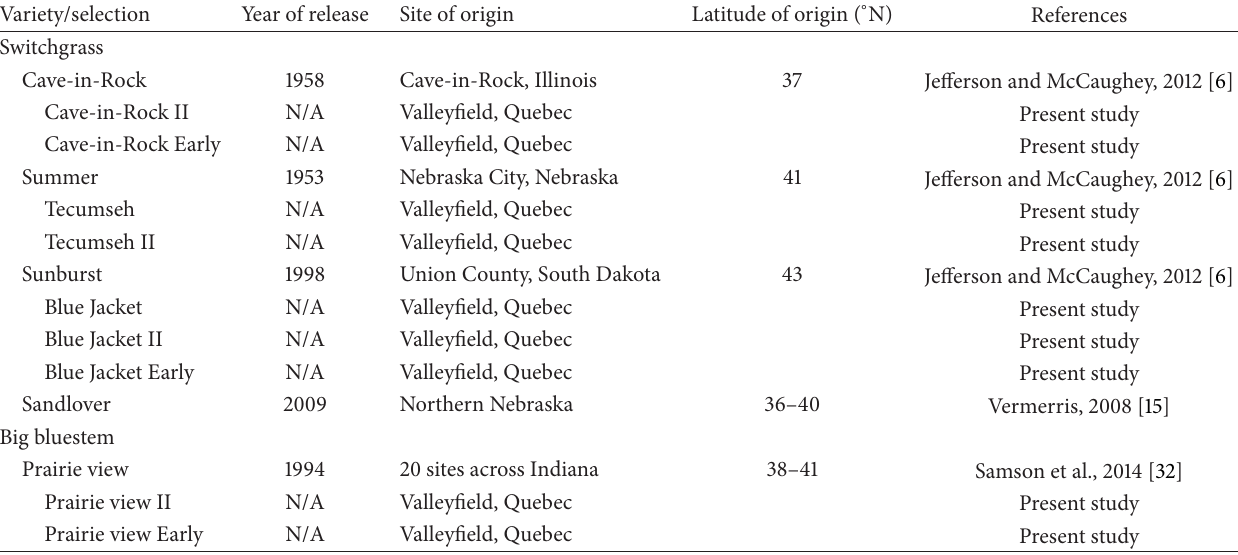
Table 1: Origins of the commercial switchgrass and big bluestem varieties evaluated in the present study and the selections derived from them through a local selection programme in Southern